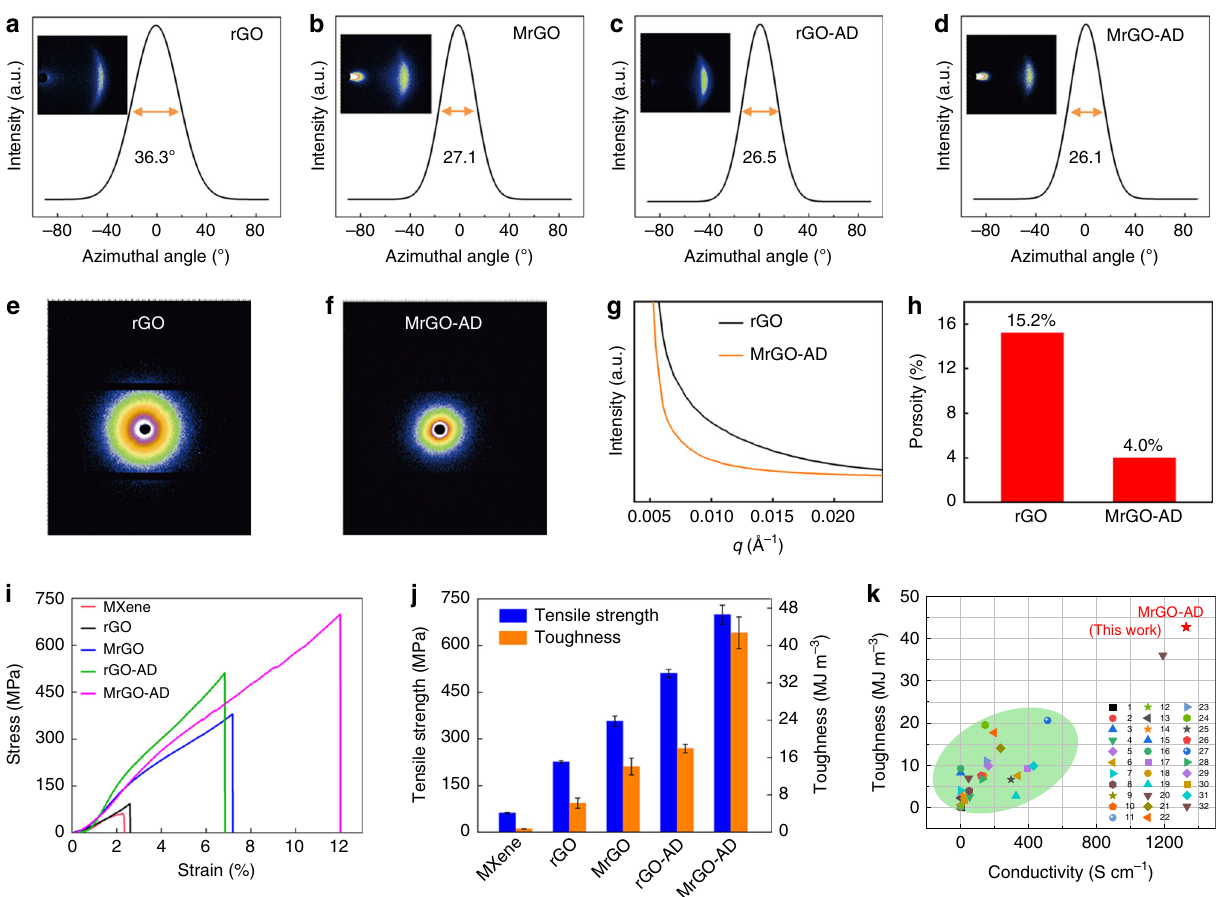
Fig. 2 Mechanical characterization. a – d Azimuthal scan wide-angle X-ray scattering (WAXS) patterns (for a rotating anode X-ray source) showing the full width at half maximum (FWHM) of a rGO. b MrGO. c rGO-AD. d, MrGO-AD. e , f The corresponding small-angle X-ray scattering (SAXS) patterns for rGO and MrGO-AD. g Comparison of SAXS scattering intensities for rGO and MrGO-AD. These results indicate a decrease in porosity in going from rGO to MrGO-AD. h Bar graphs comparing the porosity of rGO and MrGO-AD. i Typical tensile stress – strain curves for the investigated sheets. j Bar chart comparing the toughnesses and conductivity of the obtained sheets. k Comparison of tensile strength and toughness MrGO-AD sheet with that of other graphene-based